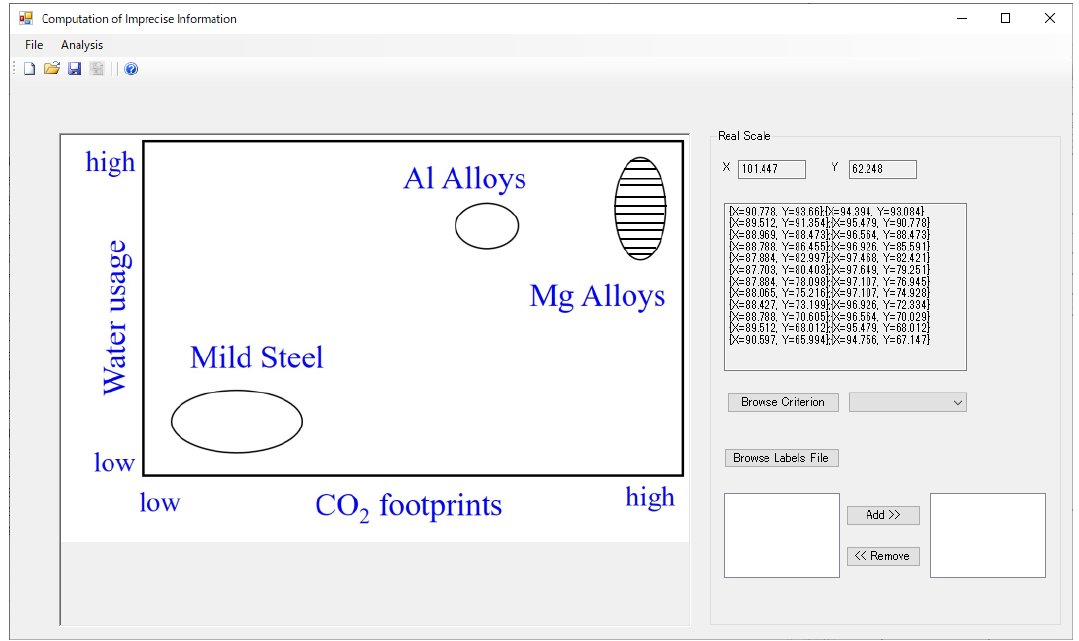
Figure 11. Extracting decision-relevant information from the plot of cost versus density.